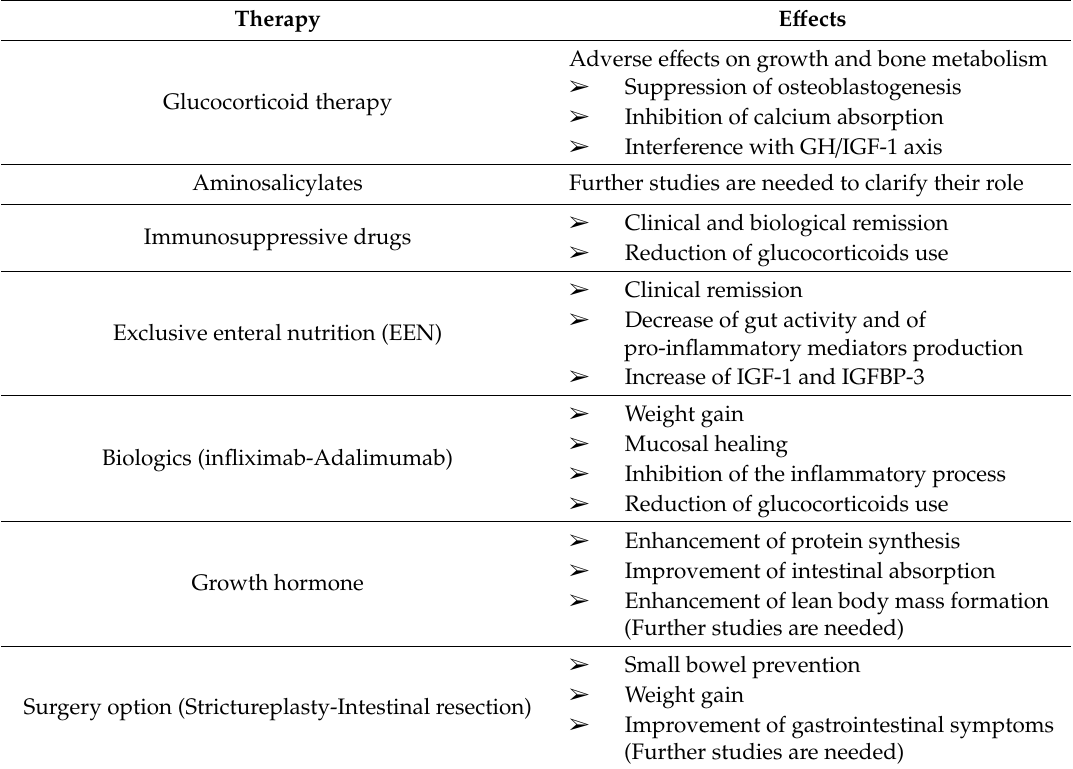
Table 2. Treatment of IBD and its e ff ects on growth failure and delayed puberty. Therapy E ff ects Adverse e ff ects on growth and bone metabolism (cid:226) Suppression of osteoblastogenesis Glucocorticoid therapy (cid:226) Inhibition of calcium absorption (cid:226) Interference with GH / IGF-1 axis Aminosalicylates Further studies are needed to clarify their role Clinical and biological remission Immunosuppressive drugs (cid:226) Reduction of glucocorticoids